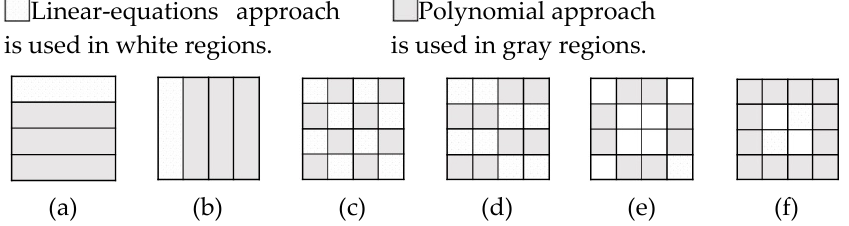
Figure 3. Six of the almost infinitely many examples of sharing a secret image by mixing the two approaches. (a) means that only the top quarter can use linear-equations approach (LEA); (b) means that only the leftmost quarter can use LEA; (c) means that only the blocks (i,j) whose i + j are even can use LEA; (d) means that only blocks {1, 2} of each odd row and blocks {3, 4} of each even row can use LEA; (e) means that only the top-leftmost, top-rightmost, bottom-leftmost, bottom-rightmost, and the 4 central blocks can use LEA; (f) means that only the 4 central blocks can use LEA.